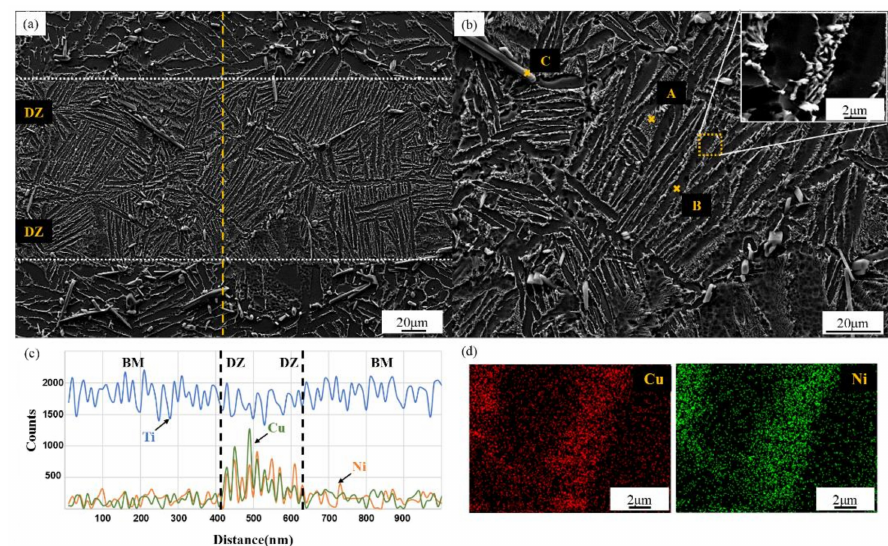
Figure 2. Microstructure and elemental distribution of the TiB w /Ti-6Al-4V composite joint brazed with Ti-Cu-Ni-Zr filler metal at 940 ◦ C for 2 h: ( a ) the whole microstructure of the joint; ( b ) a magnified view of the brazing seam; ( c ) line scanning results corresponding to line marked in ( a ); ( d ) elemental distribution maps corresponding to the magnified view of Widmanstätten in ( b ).